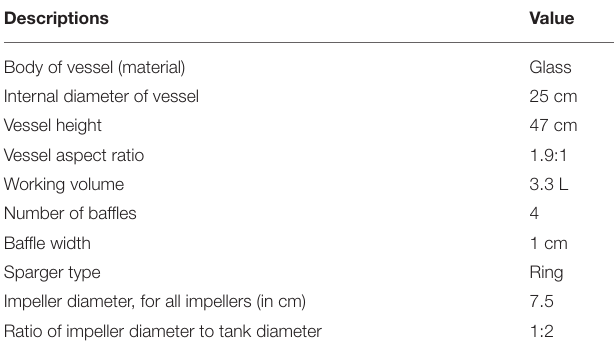
TABLE 1 | Specification of stirred tank